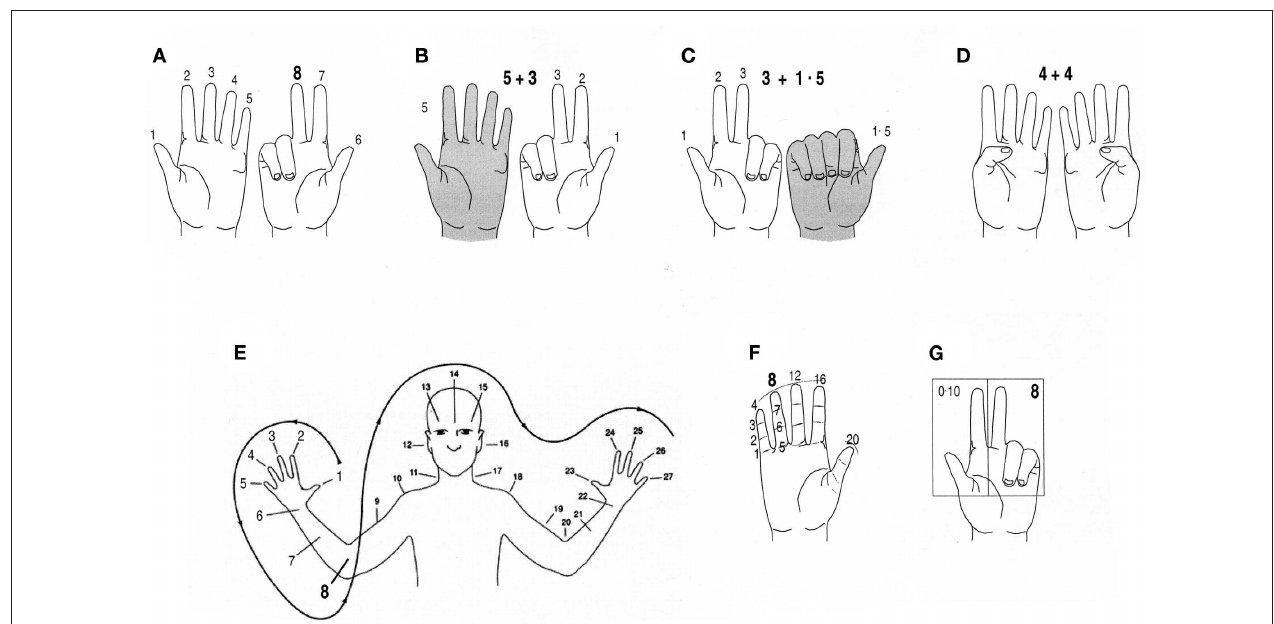
Figure 1 | Variability in finger counting systems, illustrated for number eight signs [(e) downloaded from Marmasse et al., 2000]